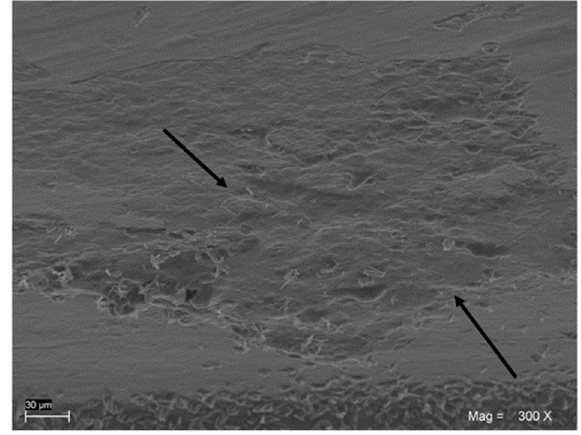
Figure 4. Group 2. After 50 disinfection cycles with hydrogen peroxide, zones of damage by the corrosive process were observed (arrows).